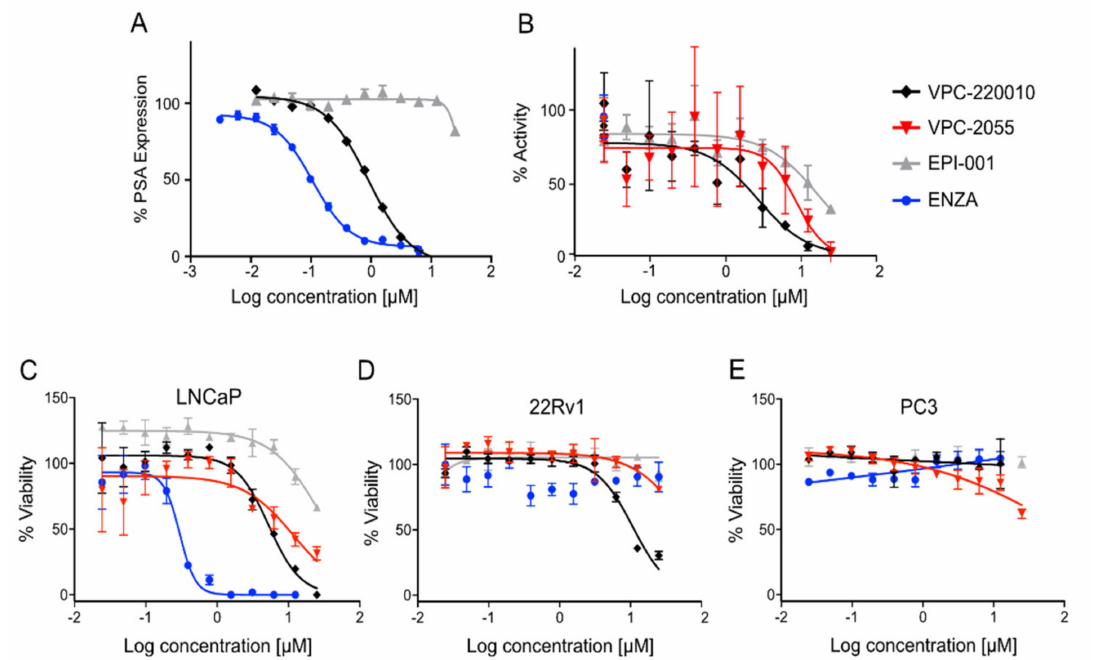
Figure 2. Effect of VPC-2055, EPI-001 and VPC-220010 on the transcriptional activity of ( A ) full-length AR in an eGFP reporter cell line; ( B ) ARV7 with a nanoluc reporter cell line; and the proliferation of ( C ) LNCaP (full length AR); ( D ) 22rv1 (full length AR and ARV7); and ( E ) PC-3 (AR null). Viability was calculated following 72 h stimulated by R1881 (DMSO vehicle: LNCaP), or with DMSO alone (22rv1, PC-3). All experiments were done as three biological replicas in triplicate (mean ±